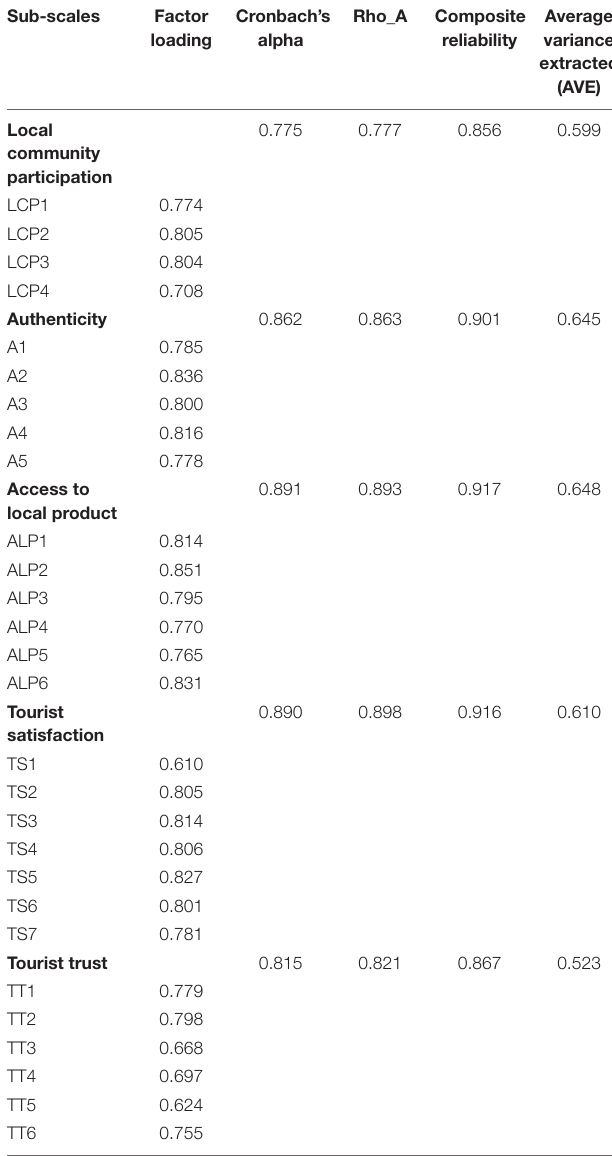
TABLE 1 | Reliability and